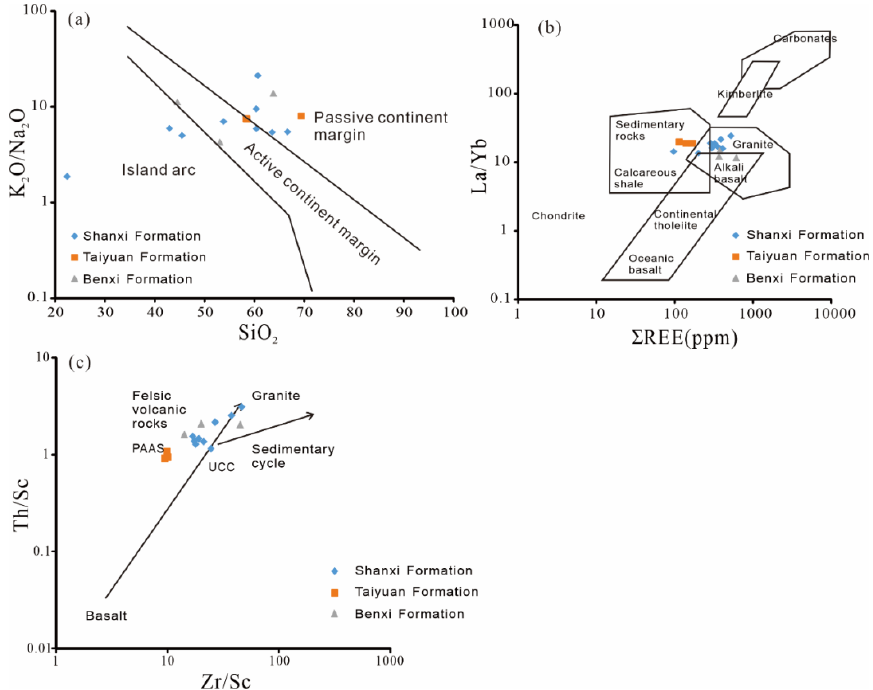
Figure 5. Plot showing structural background and sediment source for the Liulin section. ( a ) Correlation between SiO 2 and K 2 O/Na 2 O; ( b ) Correlation between rare earth element concentration ( ∑ REE) and La/Yb; ( c ) Correlation between Zr/Sc and Th/Sc for the Shanxi Formation, Taiyuan Formation, and Benxi Formation.